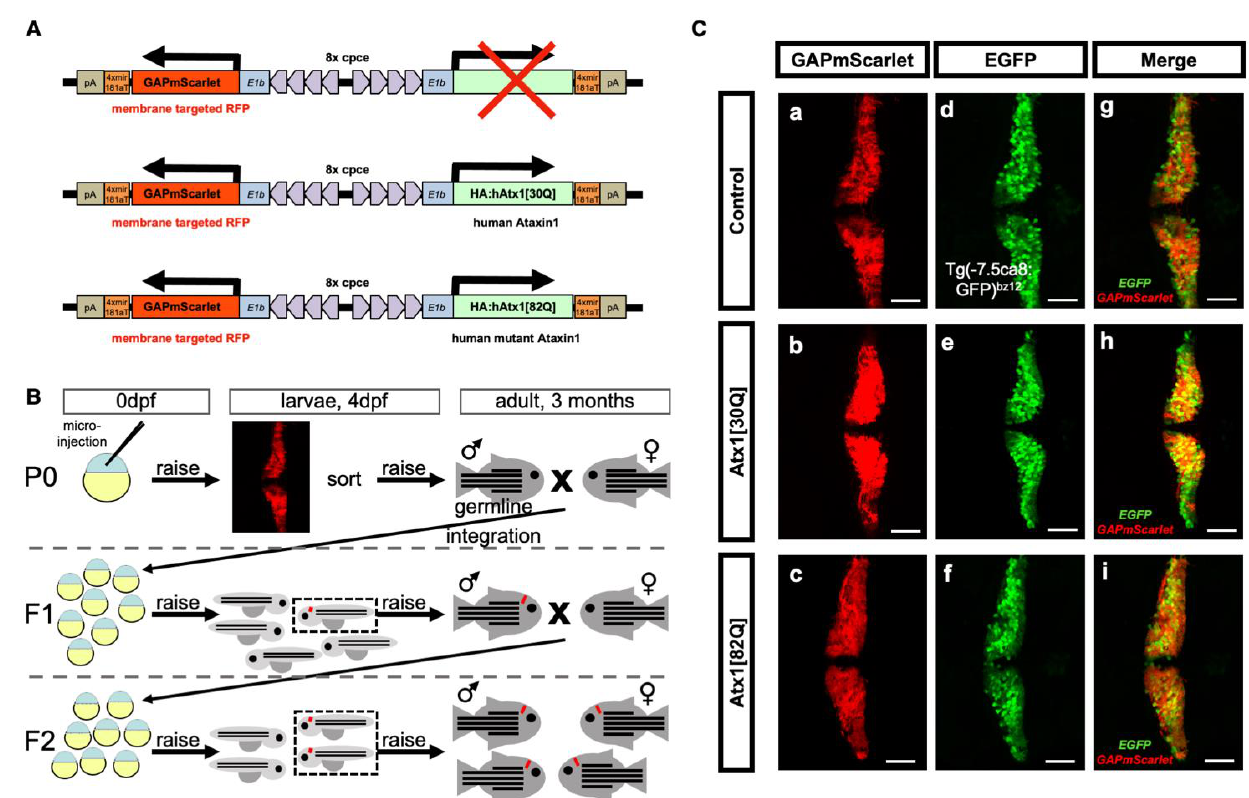
Figure 1. Generation of a stable transgenic zebrafish model for PC-specific SCA1. ( A ) Schematic drawing (not to scale) of expression constructs for PC-specific expression of red fluorescent reporter protein mScarlet targeted to the cytoplasmic membrane due to an N-terminal fusion with a post translational palmitoylation signal derived from the zebrafish GAP43 protein. This reporter is expressed alone, or coexpressed with non-pathological [30Q] and mutant pathological [82Q] alleles of human ataxin1 . Ectopic expression in tectal neurons and retinal cells was eliminated by four copies of miRNA181a target sites (4xmiR181aT) in the 3′UTR of the transgenes [25]. All bidirectional transgene cassettes are flanked by Tol1 transposase recognition sites [26]. ( B ) Schematic outline of screening and breeding procedure to obtain stable transgenic zebrafish of the F2-generation, which propagate PC-specific mScarlet and Atx1 expression in a Mendelian manner. ( C ) Analysis of GAPmScarlet expression ( a – c ) of carriers crossed into the transgenic Tg(-7.5ca8:GFP) bz12 background with PC-specific cytoplasmic EGFP expression ( d – f ) and merged images ( g – i ) to confirm PC-specific coexpression of the transgene cassette in F2 larvae at 4 dpf of the established transgenic control mScarlet (upper row), Atx1[30Q] (middle row), and Atx1[82Q] (lower row) strains, respectively. The individual images display dorsal views of the larval corpus cerebelli, anterior is to the left. Scale bar: 50 µm.